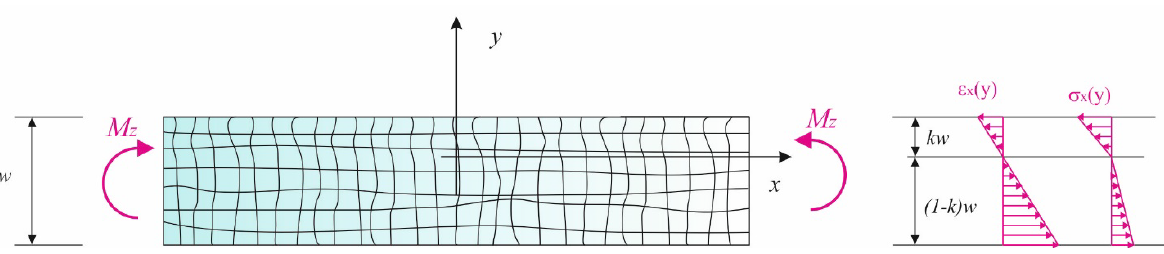
Fig. 9 Cracked laminated glass beam under in-plane bending: a) schematics and b) qualitative distribution of the axial strain and stress.